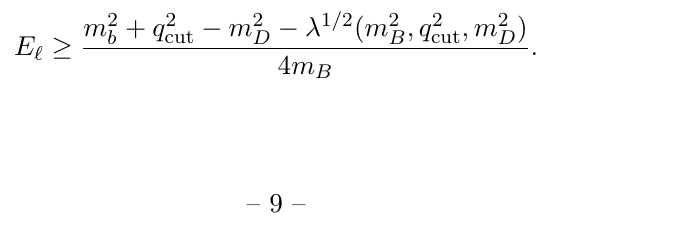
Figure 1 . Gray areas are the kinematically allowed regions in the E ‘ - E (cid:23) plane where B ! X c ‘(cid:23) events can acquire a leptonic invariant mass larger than q 2 (right). Decay modes which require a hadronic invariant mass larger than m D populate the plots in areas closer to the origin, for instance, B ! D(cid:25)‘(cid:23) and B ! DKK‘(cid:23) events only appear below the dot-dashed and dashed lines,